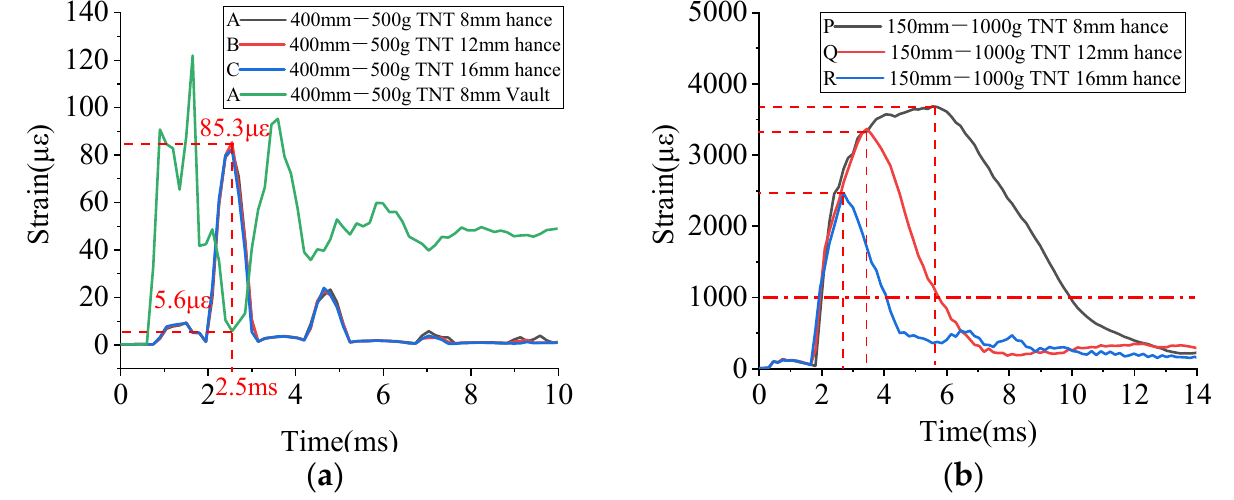
Figure 15. Time history strain curves of the BFRP bars at the vault and the hance under the working conditions of: ( a ) A, B, C and ( b ) P, Q, R.